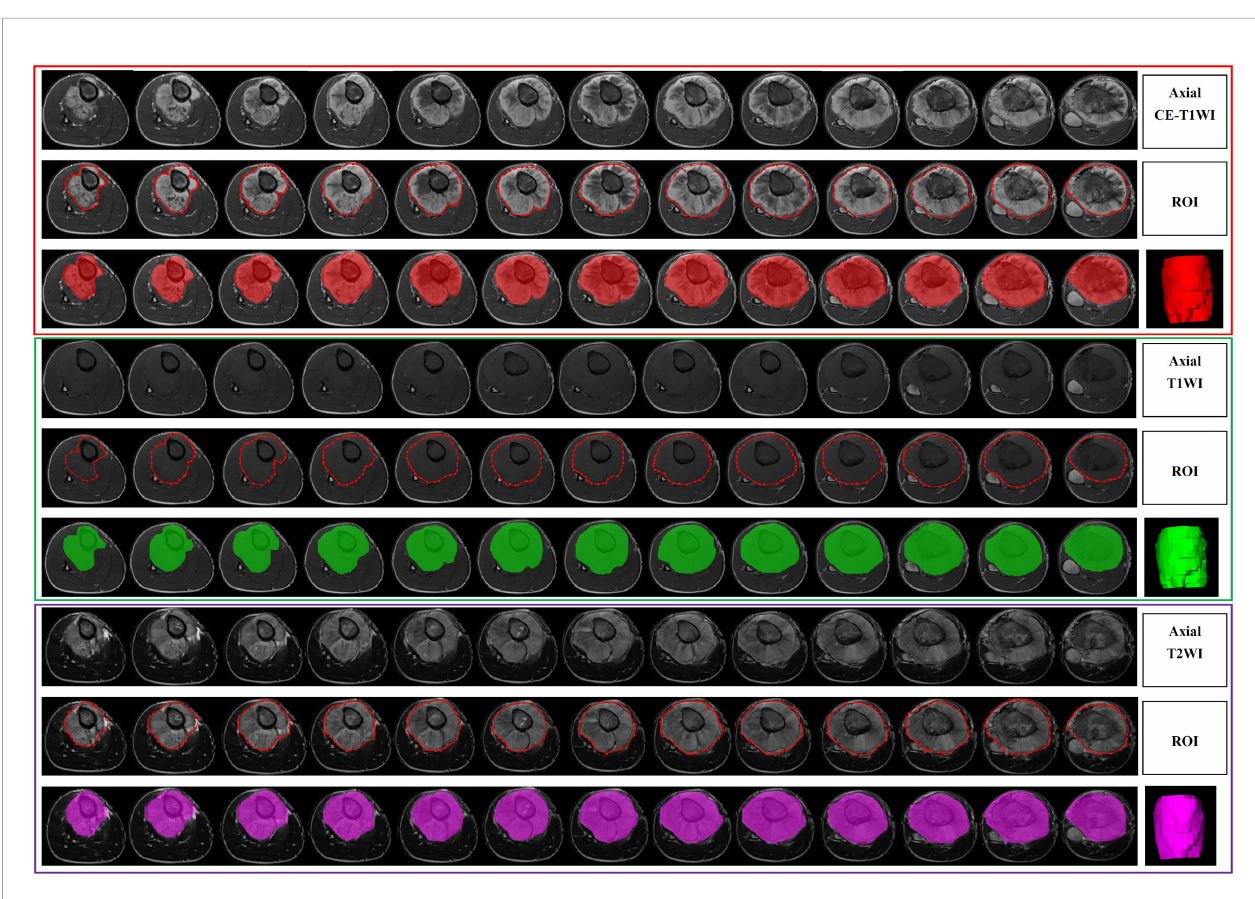
FIGURE 2 | An example of a segmented MRI